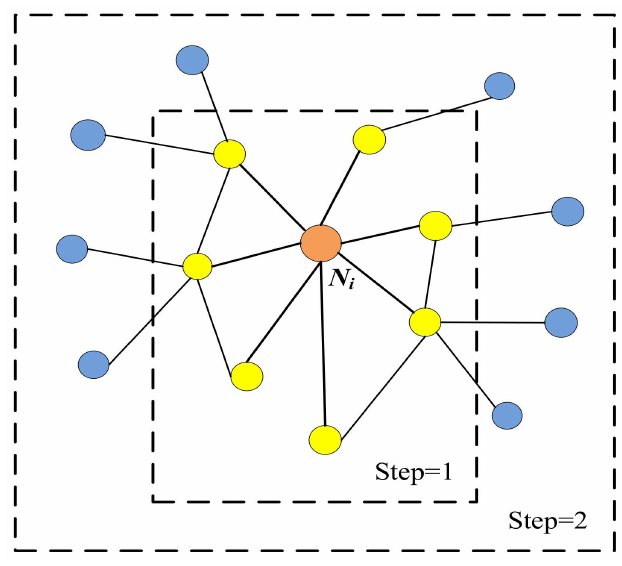
Figure 2. Visual field of artificial